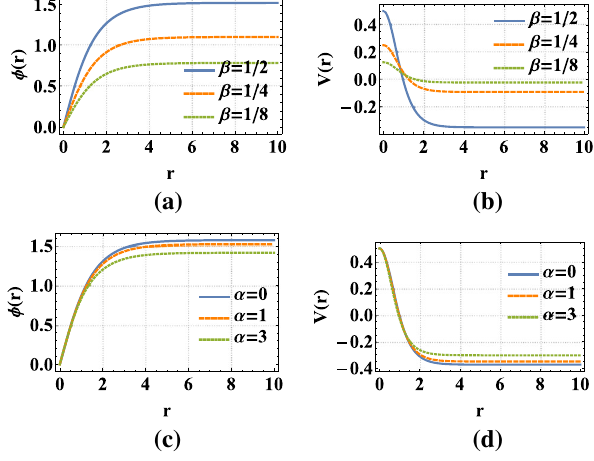
Fig. 4 The scalar field (47) and the scalar potential (45) at the limit D → 4. a The scalar field φ( r ) and b the scalar potential for different values of the parameter β and α = 1. c The scalar field and d the scalar potential for different values of the GB coupling constant and β = 1 / 2.